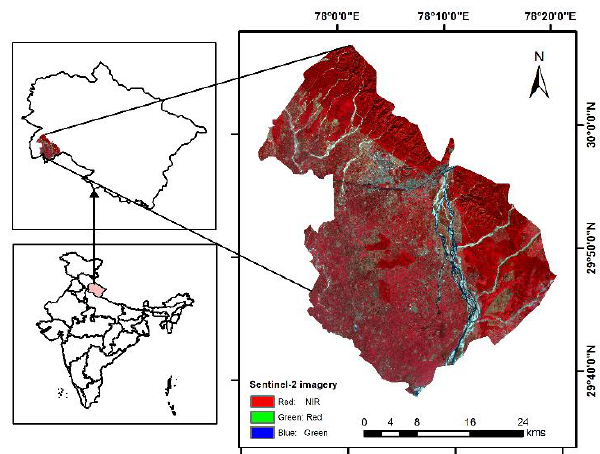
Figure 1. False color composite (FCC) of Sentinel-2 (Band 8 (NIR), 4 (Red), 3 (Green)) of study